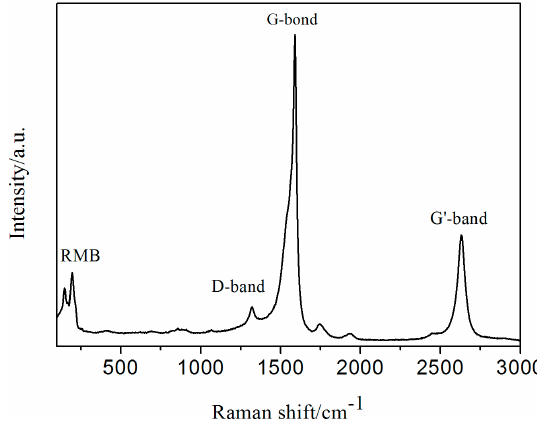
Figure 4. Raman spectra of SWCNTs.